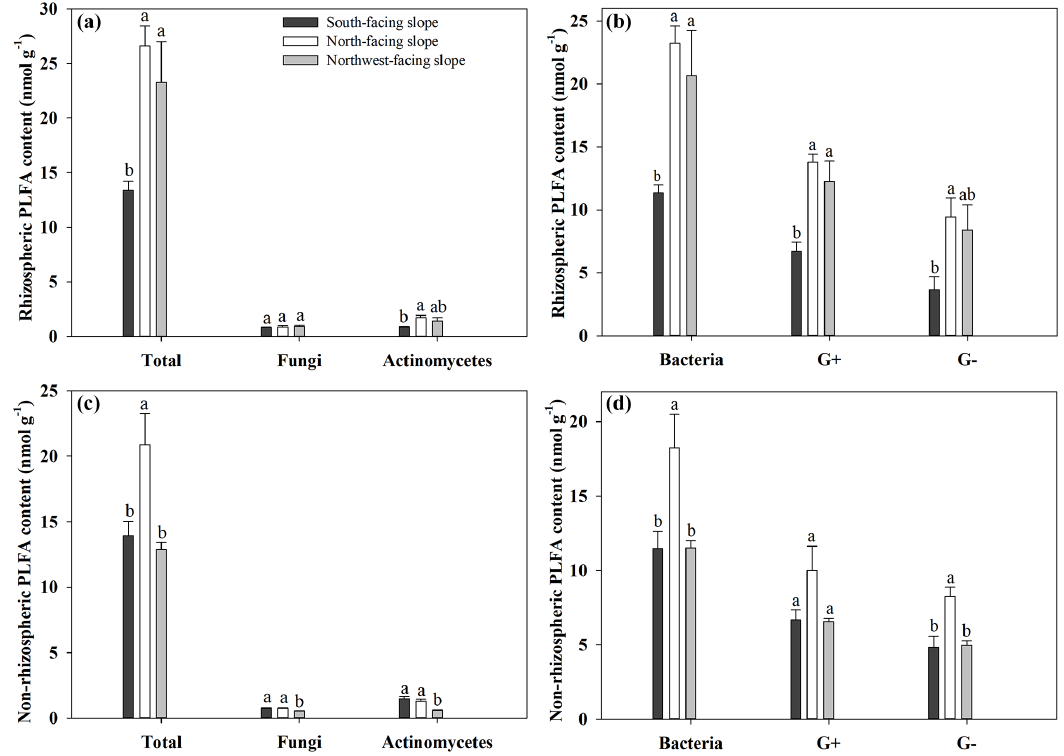
Figure 3. Effects of slope aspect on PLFA contents in rhizospheric and non-rhizospheric soils. Error bars are standard errors ( n = 3). Different letters above the bars indicate significant differences at P = 0 .